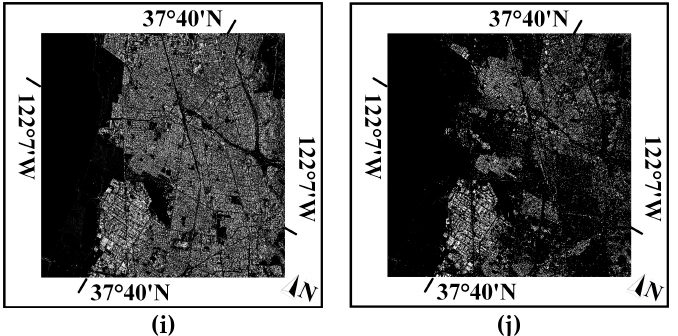
Figure 2. Decomposition results of the refined five component decomposition (R5CD). ( a )–( e ) Surface, double-bounce, volume, helix, and oblique orientation (OOB) scattering for GF-3 data, respectively. ( f )–( j ) Surface, double-bounce, volume, helix, and OOB scattering for UAVSAR data, respectively.